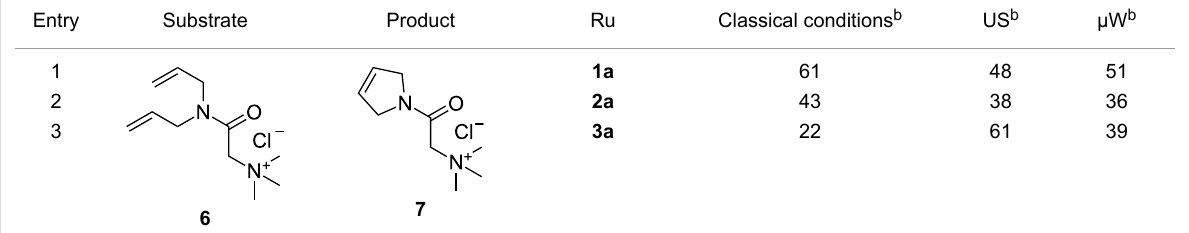
a Reaction conditions: D 2 O/iPrOH 2:1 (v/v), Ru catalyst (1 mol %), 36 °C, 2 h. b Conversions determined based on